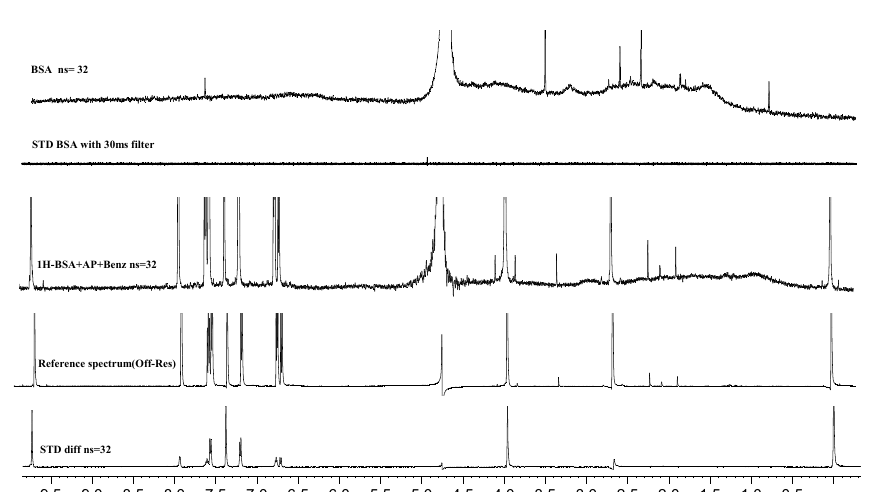
Figure 1. A) The top, 1 H-NMR spectrum of 50 µM BSA in phosphate buffer with the pH 7.4 solution, showing a characteristic broad signal obtained by using three mm NMR tube. B) STD Spectrum of protein with 30 ms of Spinlock filter, showed a complete removal of the protein signal from the spectrum. C) A 1 H-NMR spectrum of 50 µM BSA with 5 mM of each, 2-aminopyridine and isovanillin. D) A reference spectrum ( off- resonance) obtained with a cascade of 40 Gaussian shaped soft pulses, 2 seconds of saturation time and by applying 30 ms of spin lock filter (T ). For STD spectra, on -resonance saturation pulse was placed at −0. 5 ppm, while the 1p off -resonance at 30 ppm. E) A STD difference spectrum obtained by internally subtraction via phase cycling. All above spectra were produced on Bruker 600MHz AVANCE III spectrometer with a cryogenic TCI probe at 298 K